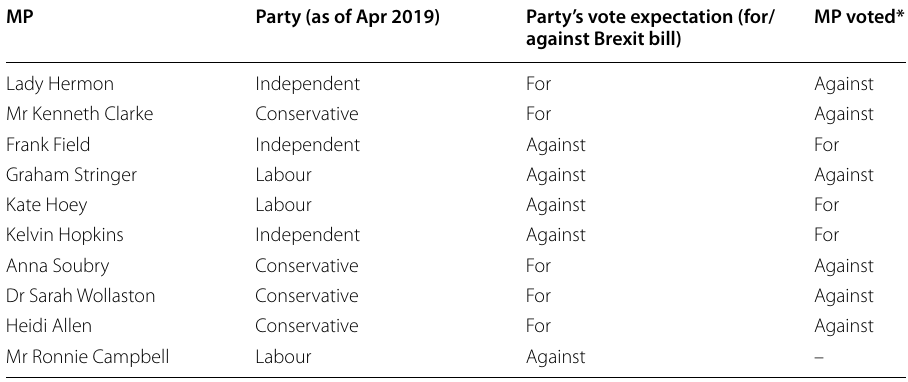
Table 3 Division votes on the Oct 2019 Brexit bill timeline of top 10 rebels compared to what is expected by their